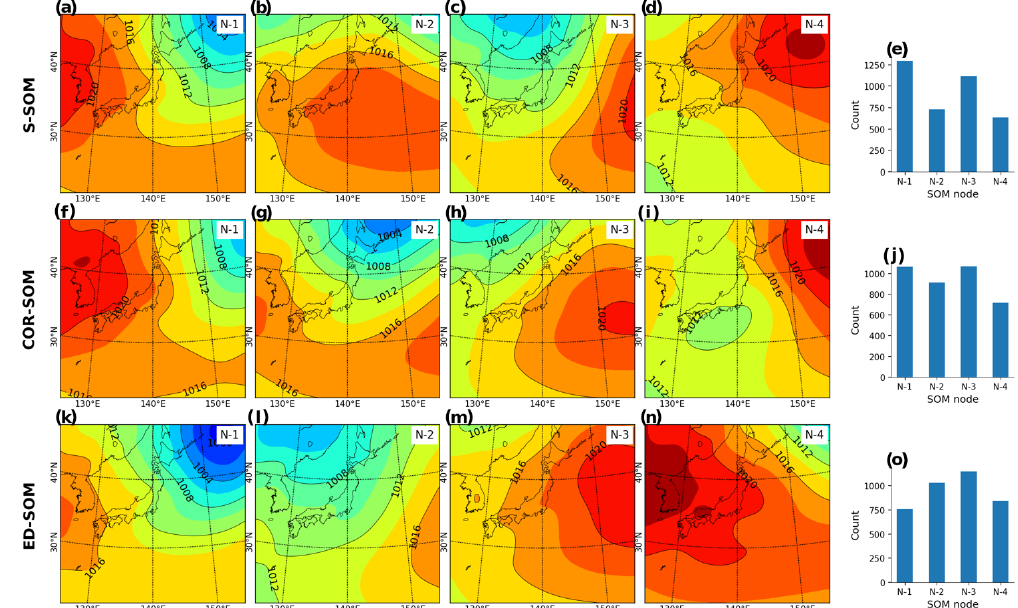
Figure A2. Spring (MAM) MSLP pattern revealed by SOMs. Panels (a) – (d) show S-SOM patterns (with four nodes); panel (e) shows the number of daily MSLPs classified as nodes 1 to 4. Panels (f) – (i) show the same result but for COR-SOM; (k) – (o) for